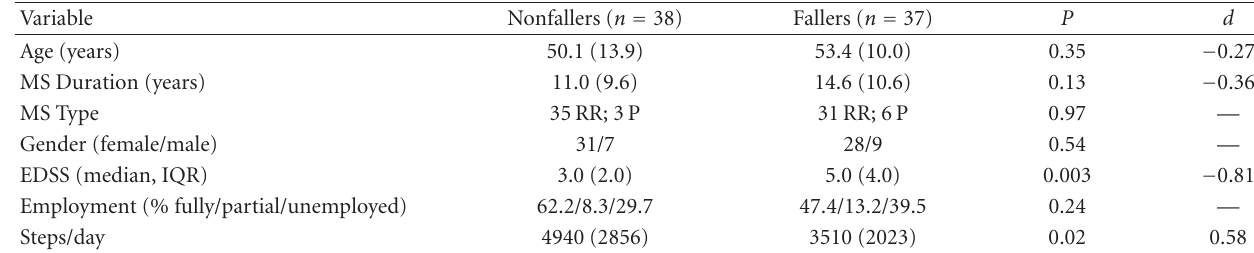
Table 1: Participant demographics and physical activity as a function of